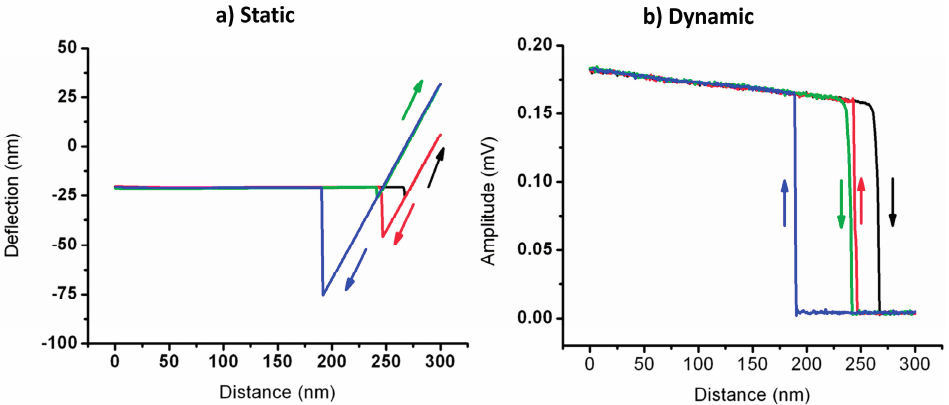
of the cantilever and ( b ) amplitude of the resonance frequency plotted as a function of tip distance from the substrate. Black and red curves represent data for empty cantilever, while green and blue curves represent the data for liquid-filled cantilever. Reprinted with permission from